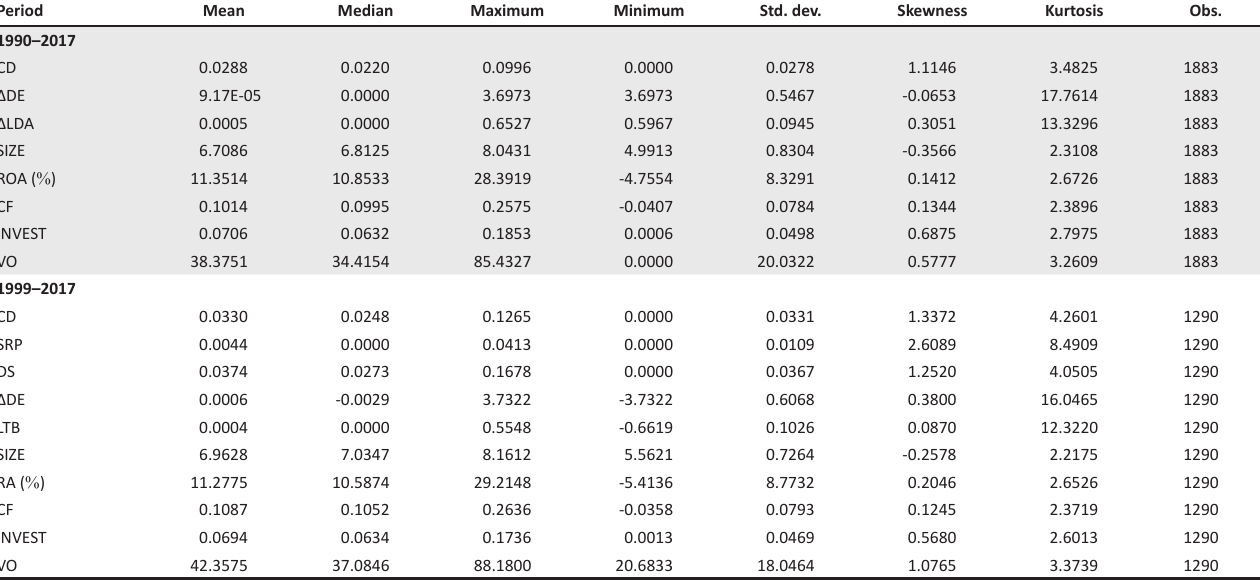
TABLE 1: Descriptive statistics for the threshold regression estimation